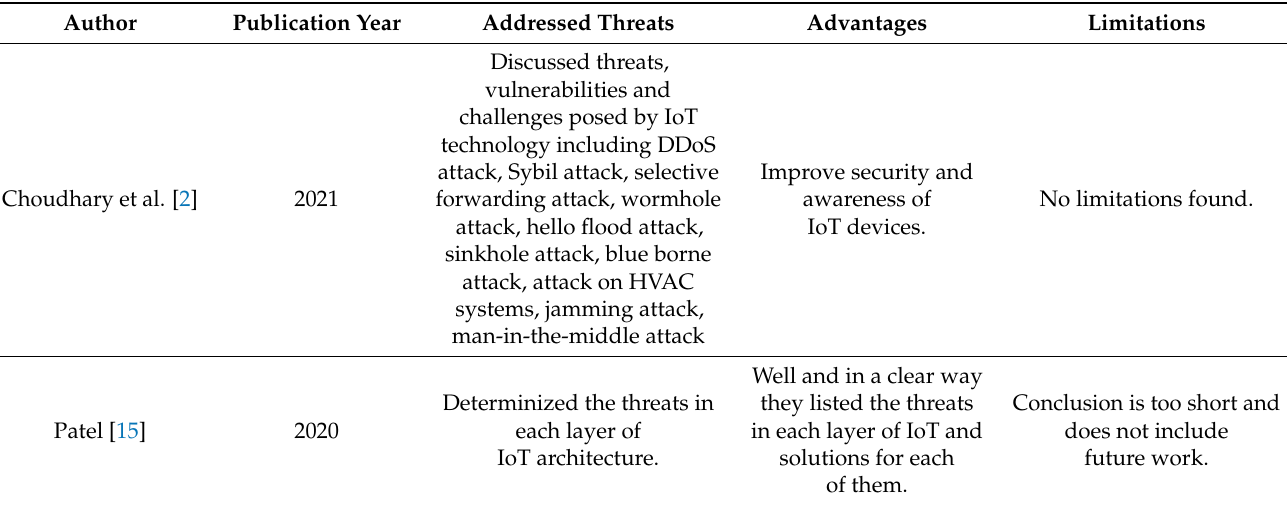
Table 4. Summary of the addressed